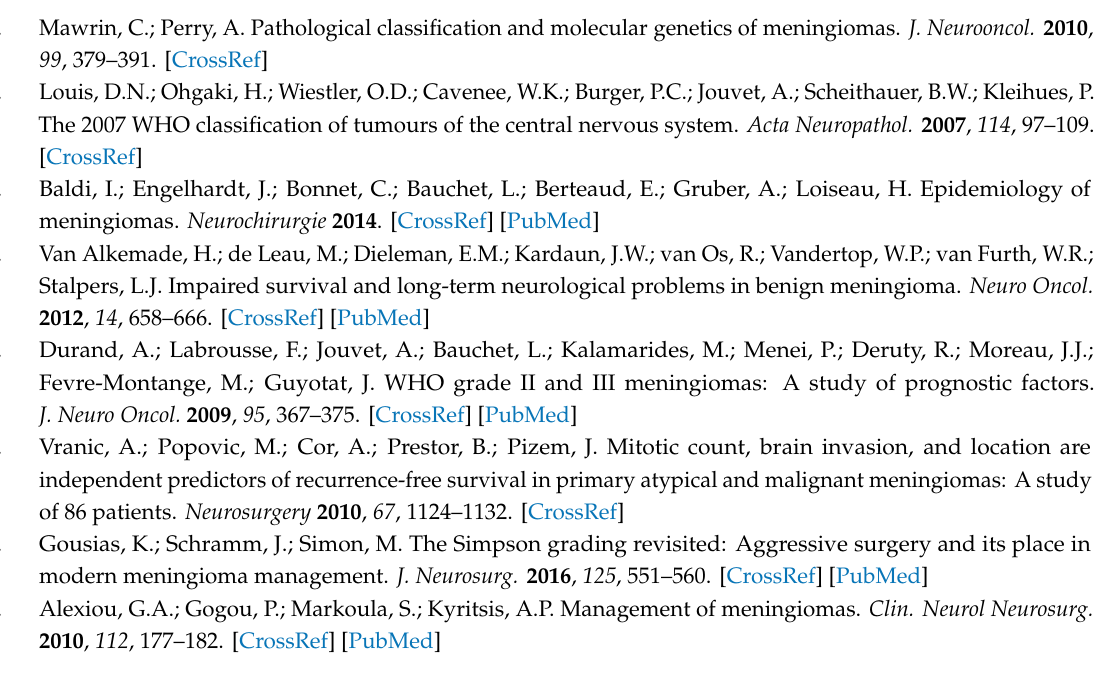
Figure S1: E ffi ciency of siRNA-mediated knockdown evaluated by qRT-PCR, Figure S2: Knockdown of KIFC1, KIF4A, KIF14 and KIF20A failed to show a robust e ff ect in both meningioma cell lines, Table S1: Primer sequences, Table S2: Clinical data of meningiomas employed for protein expression analysis (n = 30), Table S3: Comparative expression of kinesin family members in a published microarray dataset, Table S4: Panel Sequencing data of NCH93